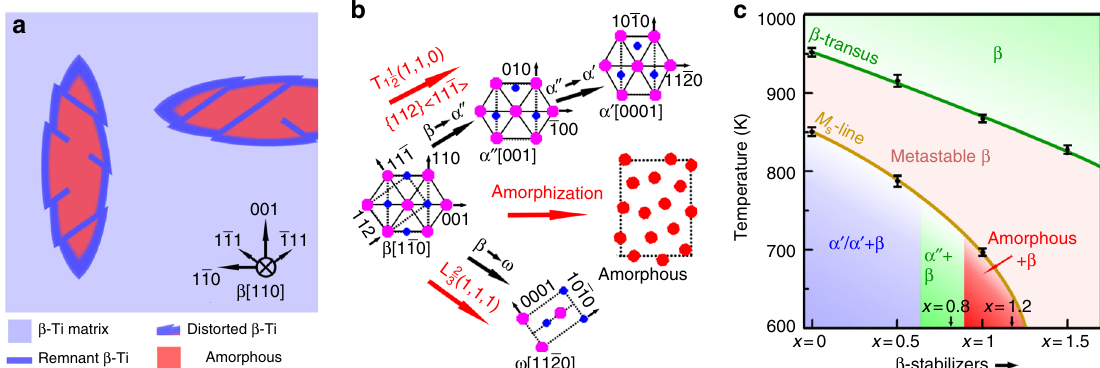
Fig. 5 Schematic depiction of the martensitic amorphization. a Sketch of the observed microstructure illustrating the lenticular amorphous regions and their preferred orientations along < 110 > β or < 001 > β . A f 112 g 111